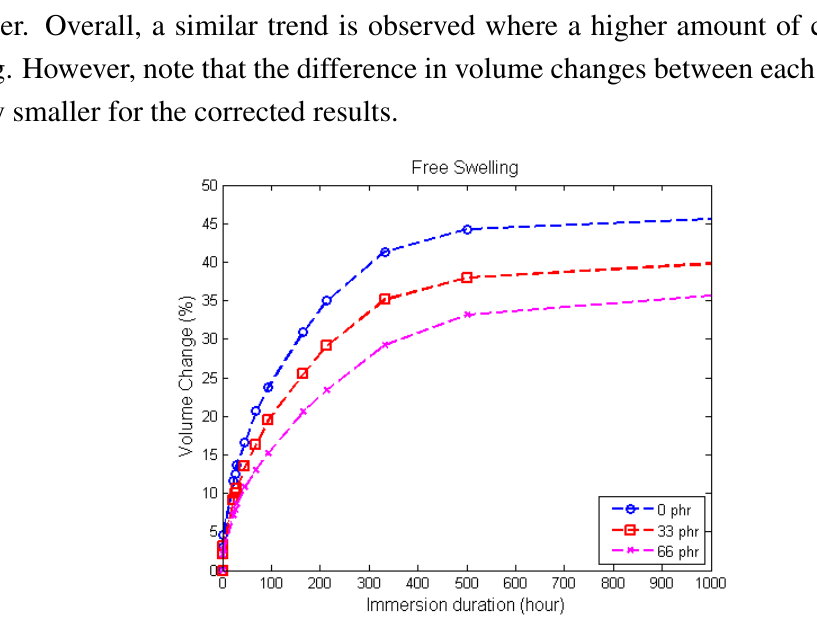
Figure 5. Corrected volume change undergone by the specimens with different carbon black